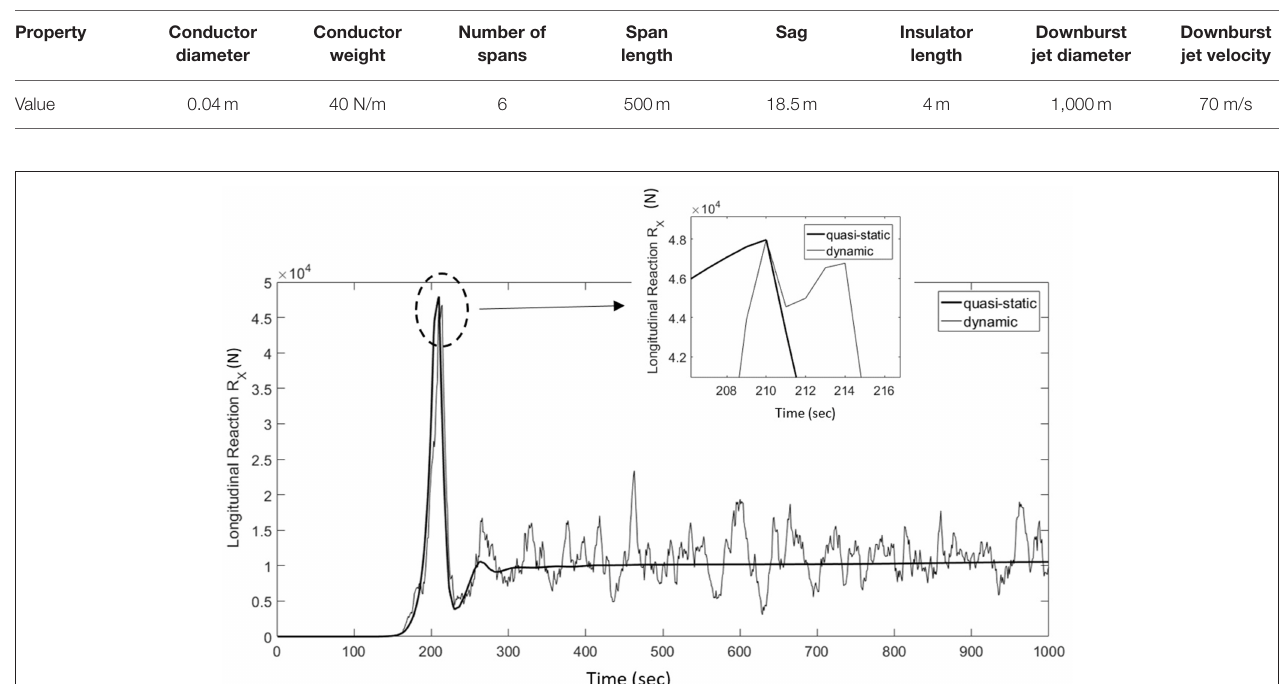
FIGURE 9 | Time history of longitudinal reaction for quasi-static analysis compared to dynamic analysis.